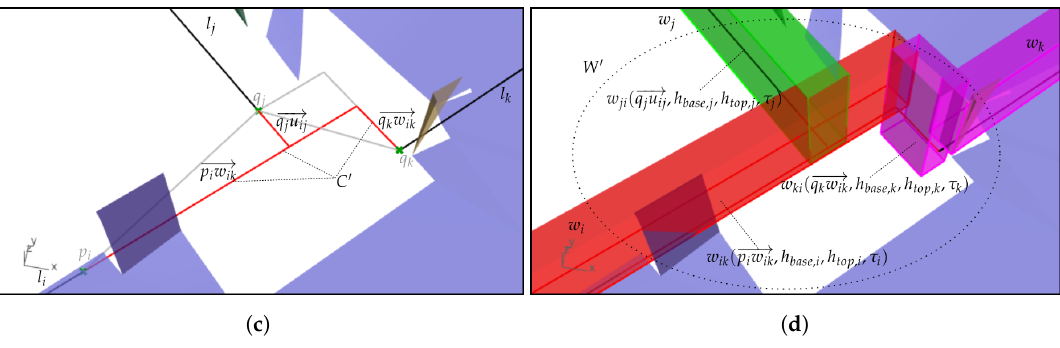
Figure 3. Wall topology reconstruction procedure of 3 interlocking walls. The reoccurring elements in each figure are the partial wall axes L = { l i , l j , l k } (black), their wall segments and the floor segments (purple). ( a ) Neighborhood selection ( b ) Candidate connections ( c ) Candidate selection ( d ) Wall